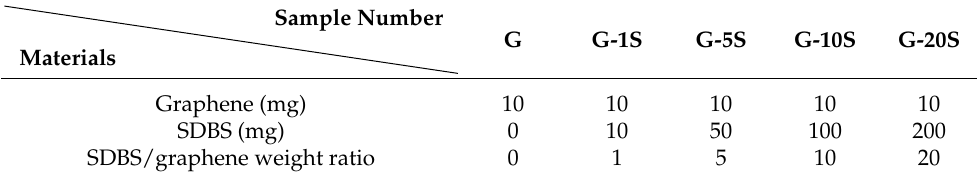
Table 1. The composition of modified graphene samples.